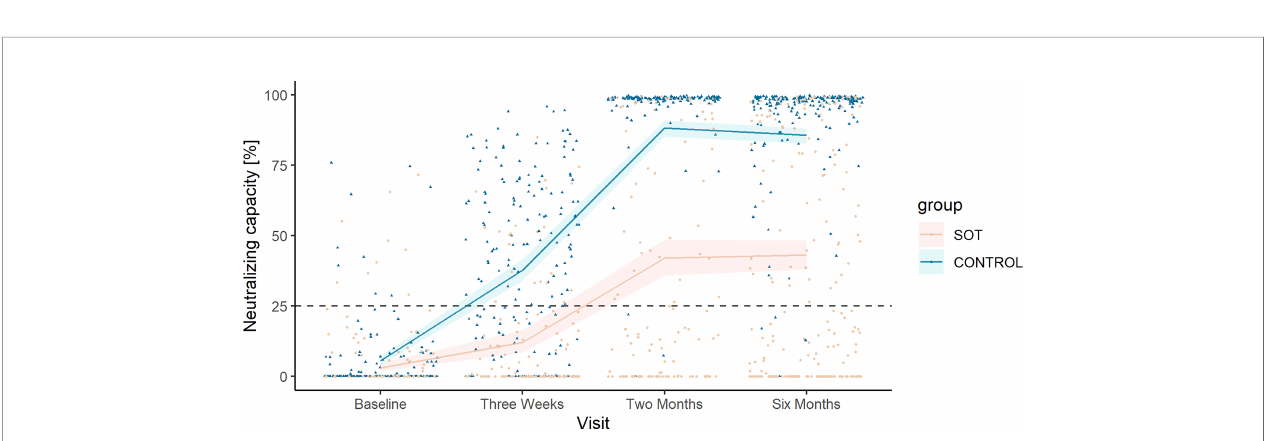
FIGURE 2 | Observed anti-receptor-binding domain (RBD) immunoglobulin G (IgG) concentration and predicted geometric mean concentration (GMC) of anti-RBD IgG in solid organ transplant (SOT) recipients and controls. Development in predicted anti-RBD IgG concentration represented in AU/ml plotted on top of the observed individual concentration of anti-RBD IgG from the day of the fi rst vaccination to 228 days after the fi rst vaccination from SOT recipients (yellow) and controls (blue). The dashed horizontal line indicates the minimum threshold for positive humoral response.